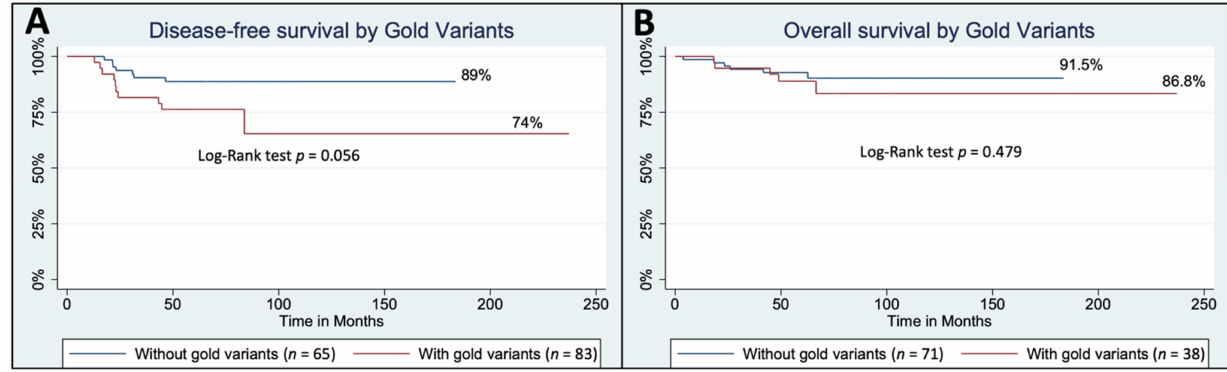
Figure 3. Survival analyses of YBC patients carrying Gold variants. ( A ) Disease free survival. ( B ) Overall